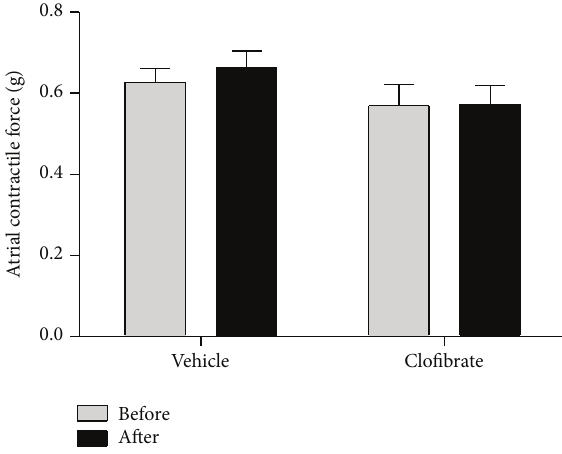
Figure 3: Contractile force before and after incubation of ouabain in vehicle- and clofibrate-treated groups. Data are shown as mean ± SEM. Six rats were used in each